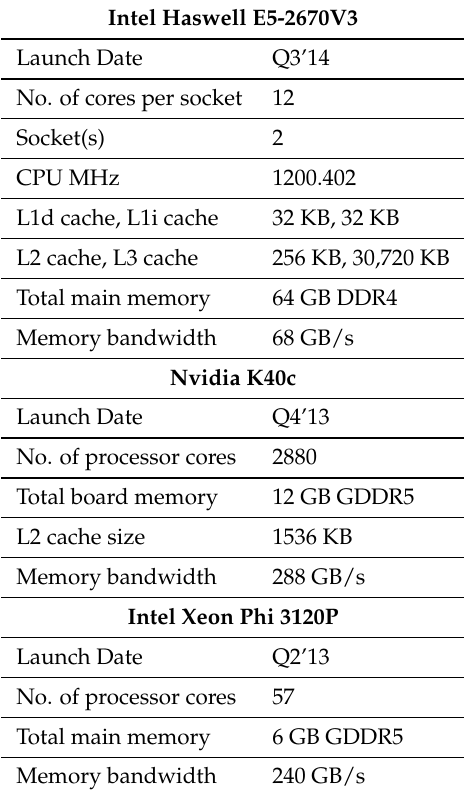
Table 1. HCLServer1: Specifications of the Intel Haswell multicore CPU, Nvidia K40c and Intel Xeon Phi 3120P.